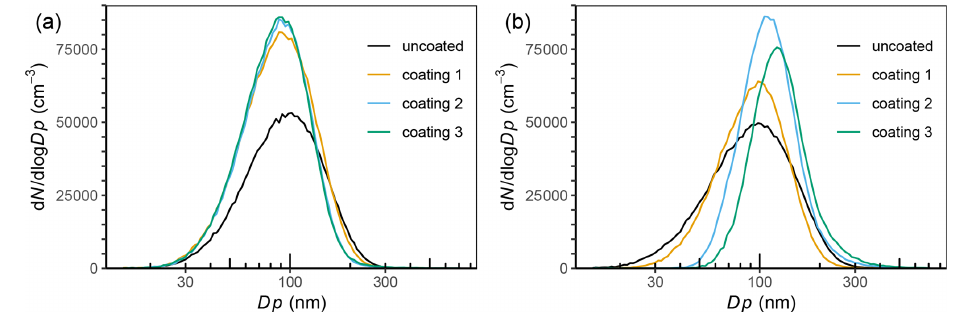
Figure 2. Mobility size distributions as measured by SMPS (a) with setup 1 and (b) with setup 0.1.